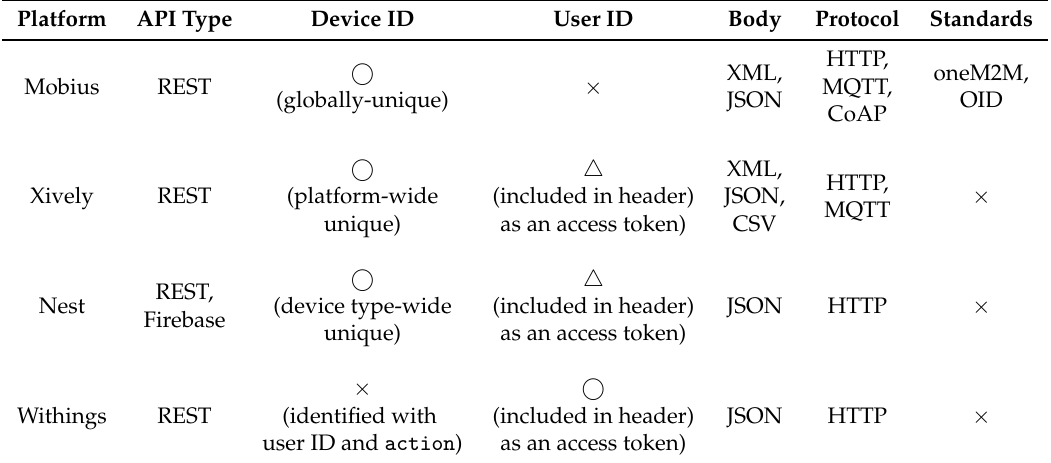
Table 1. Comparison of Mobius API and commercial APIs provided by Xively, Nest, and